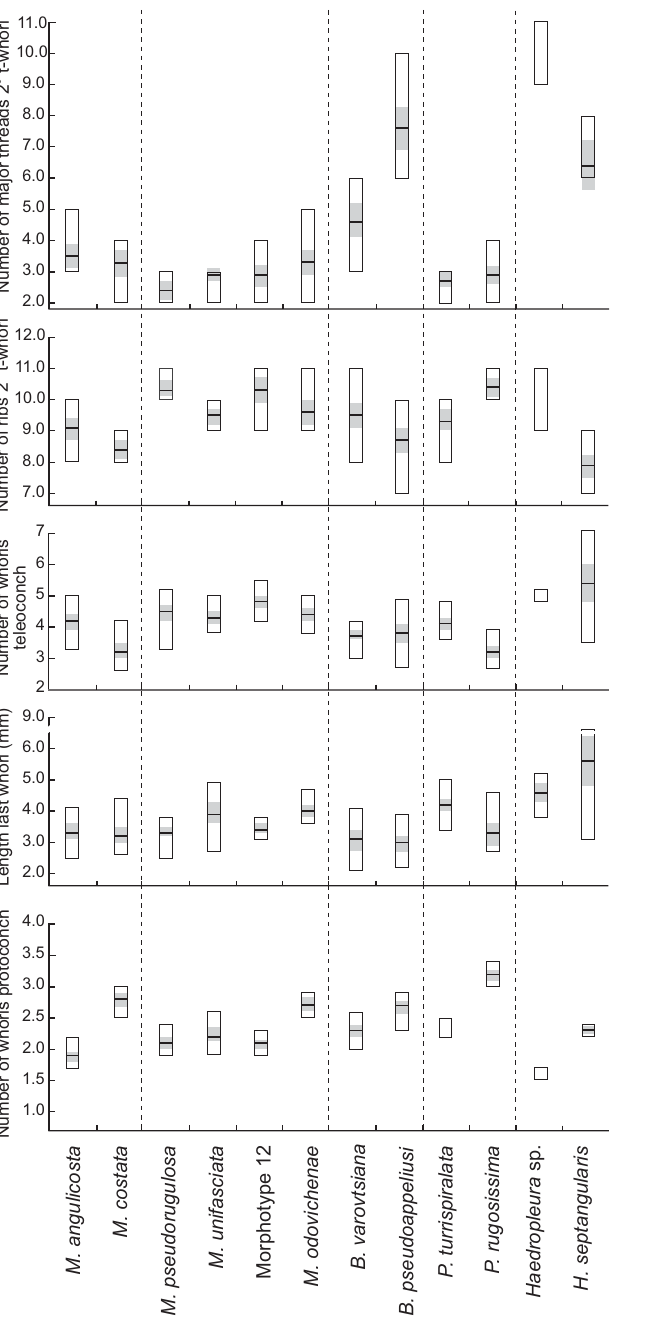
Fig. 2. Comparison of 10 assessed variables between allied taxa: sample mean, horizontal line; 95% confidence intervals (CI), shaded boxes; ranges, open